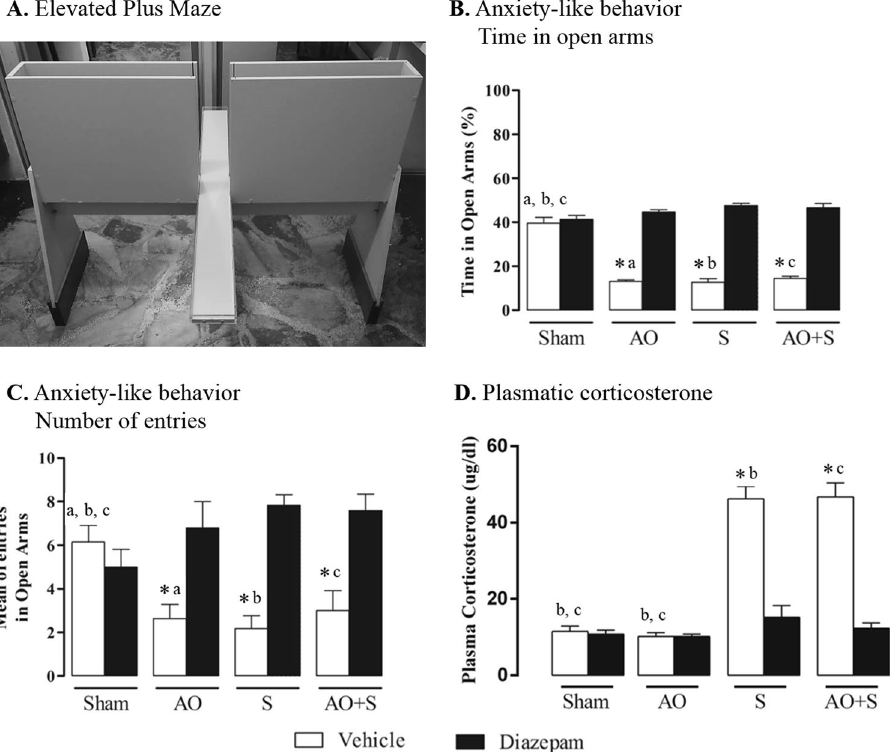
Figure 2. Effects of stress, occlusal instability and diazepam treatment on anxiety-like behavior and corticosterone hormone. ( A ) Graphical representation from EPM apparatus. Effects of stress and unilateral exodontia on time spent in open arms ( B ) and on the percentage of entries into the open arms ( C ) in the EPM test. Two-way ANOVA showed an effect of diazepam therapy in rats submitted to altered occlusion (AO), chronic stress (S) or both (AO + S) (n = 10 per group). ( D ) Analysis of plasma corticosterone levels of control rats and rats submitted to altered occlusion (AO), chronic stress (S) or both (AO + S) (n = 8 per group). Two-way ANOVA showed an effect of chronic unpredictable stress, in which S and AO + S groups presented increased plasma corticosterone compared to the other groups. Data are expressed as the means ± SEM. * P < 0.05 vs diazepam treatment; a P < 0.05 vs AO + vehicle; b P < 0.05 vs S + vehicle; c P < 0.05 vs AO + S + vehicle. SEM: standard error